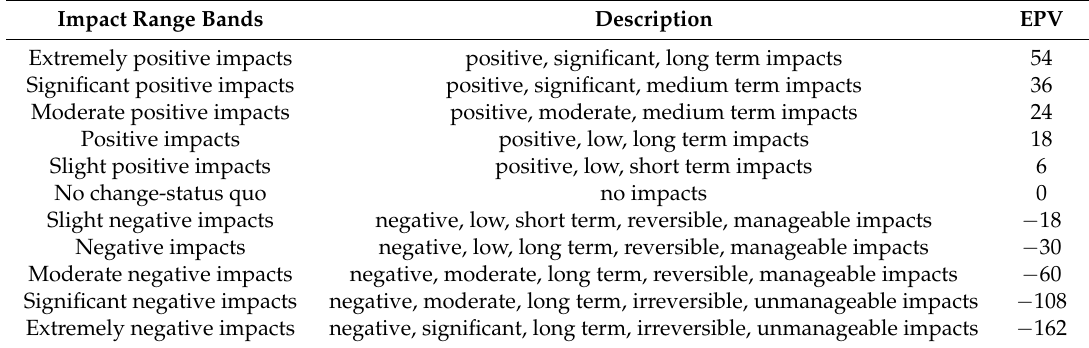
Table 1. Relation of Environmental Performance Value (EPV) to impact range